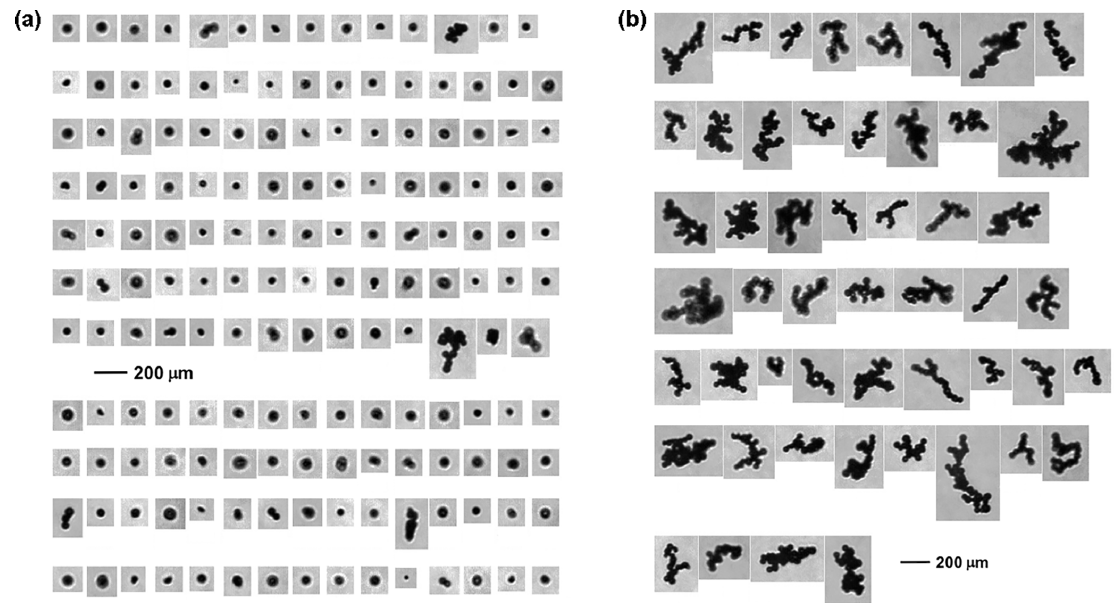
Figure 1. (a) Example CPI images of ice crystals observed at T = − 58 . 16 ◦ C (altitude of 12.11km) between 22:12:13 and 22:12:19UTC, and (b) example CPI images of ice crystals observed at T = − 57 . 72 ◦ C (altitude of 12.03km) between 22:21:02 and 22:22:14UTC. The 200µm scale bar is embedded in each